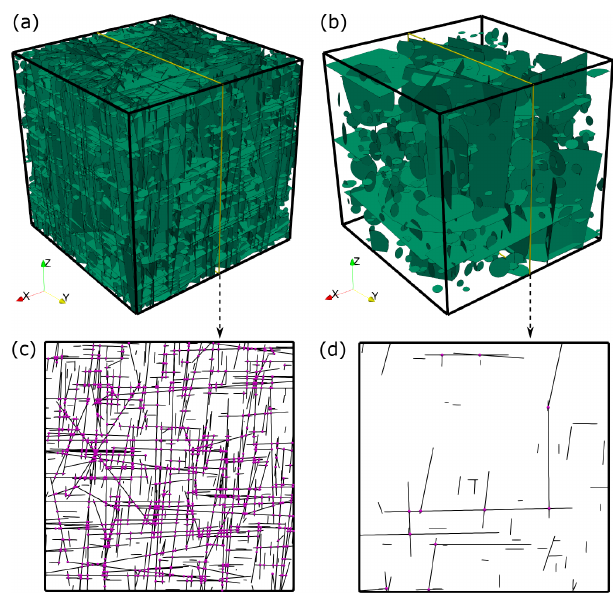
Figure 9. Panels (a, b) display the test DFNs with 10000 and 1000 fractures, respectively. Both are generated with the software ADFNE (Alghalandis, 2017), whereas input parameters are given in the text. Yellow lines depict the location of the slice shown in (c, d) . Black lines indicate fractures and magenta spheres the loca- tion of fracture